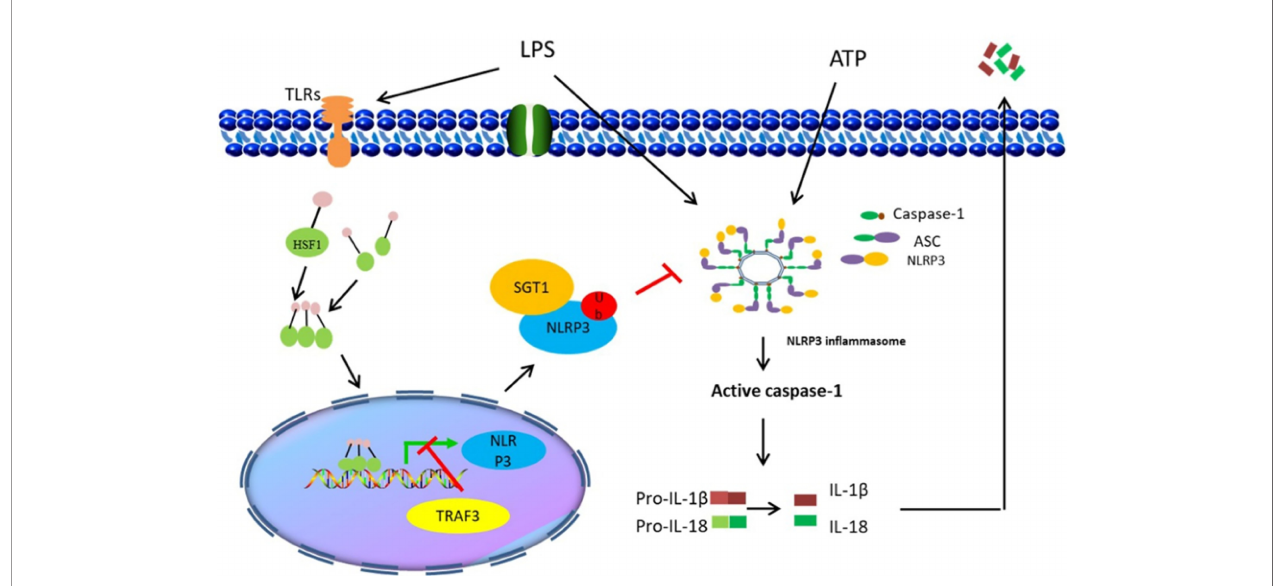
FIGURE 8 | Illustration of HSF1 protecting sepsis-induced acute lung injury by inhibiting NLRP3 in fl ammasome